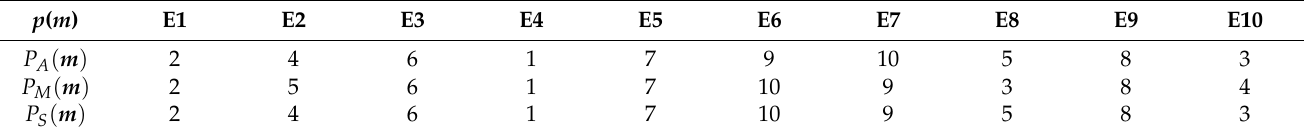
Table 8. Final rankings of multiple TOPSIS analysis.